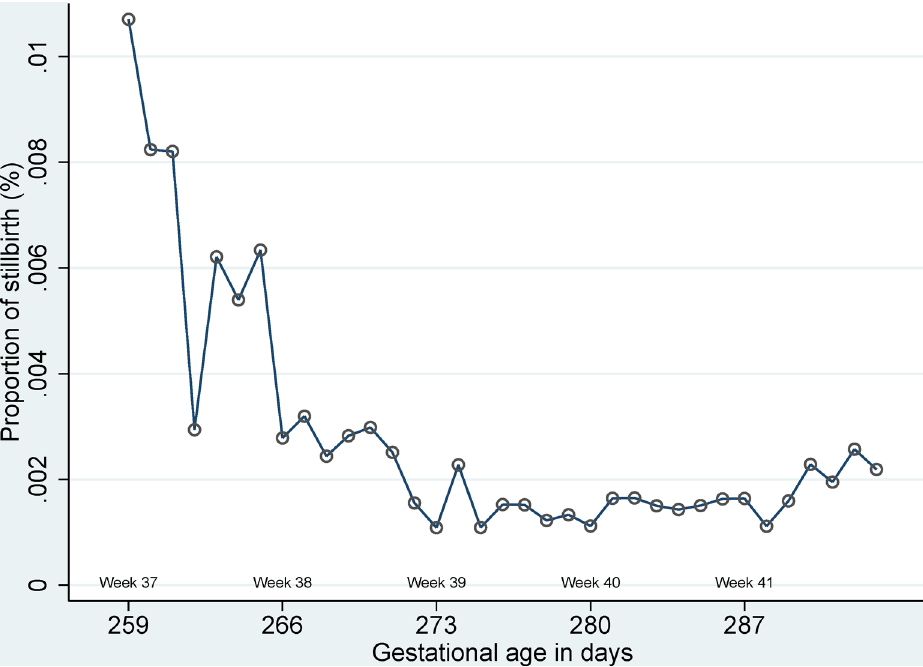
Fig 8. Proportion of stillbirth according to gestational age in